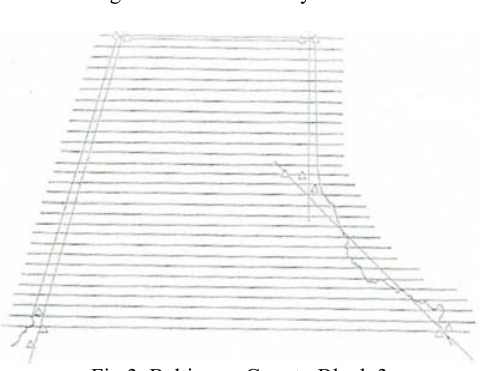
Fig.2. Baltimore County Block 2